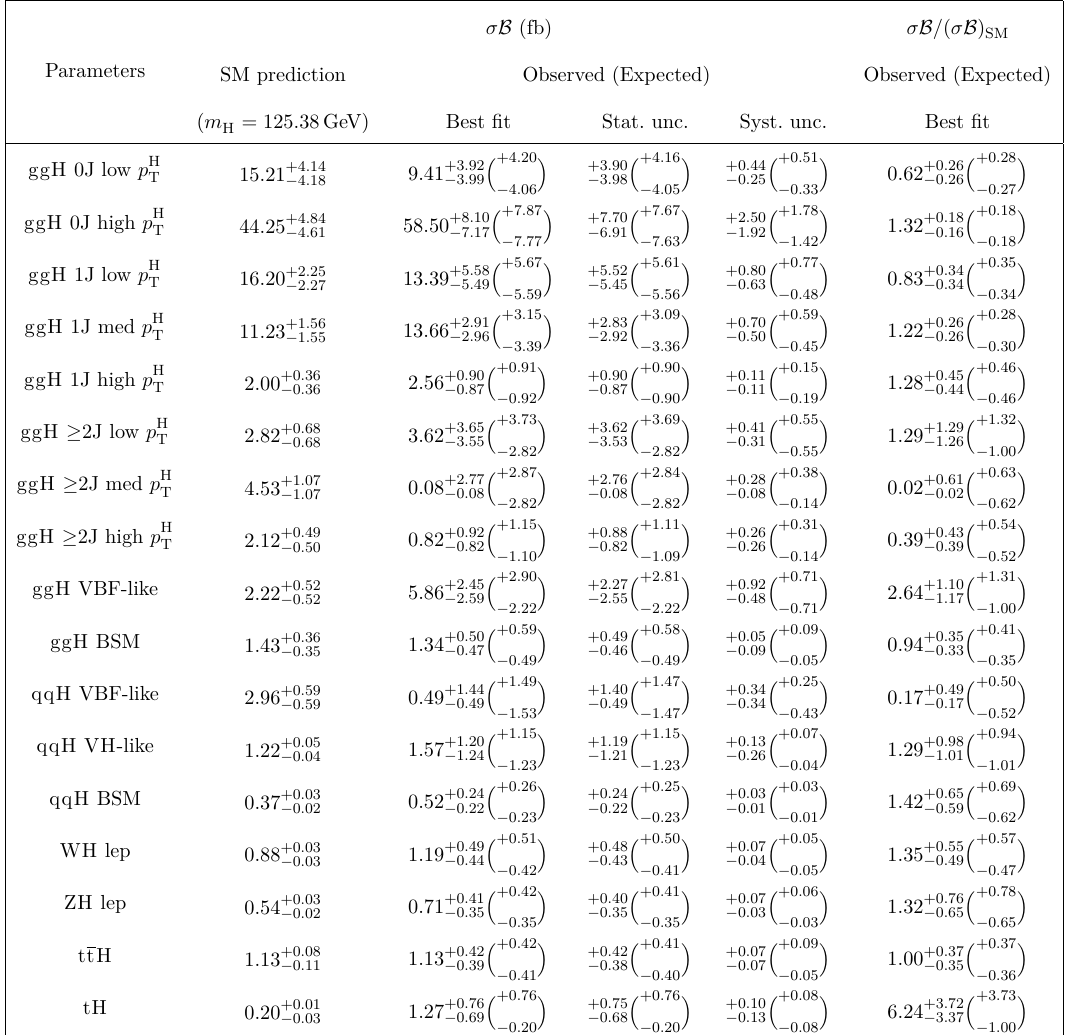
Table 12 . Results of the maximal merging scheme STXS fit. The best fit cross sections are shown together with the respective 68% CL intervals. The uncertainty is decomposed into the systematic and statistical components. The expected uncertainties on the fitted parameters, computed assum- ing the SM predicted cross section values, are given in brackets. Also listed are the SM predictions for the cross sections and the theoretical uncertainty in those